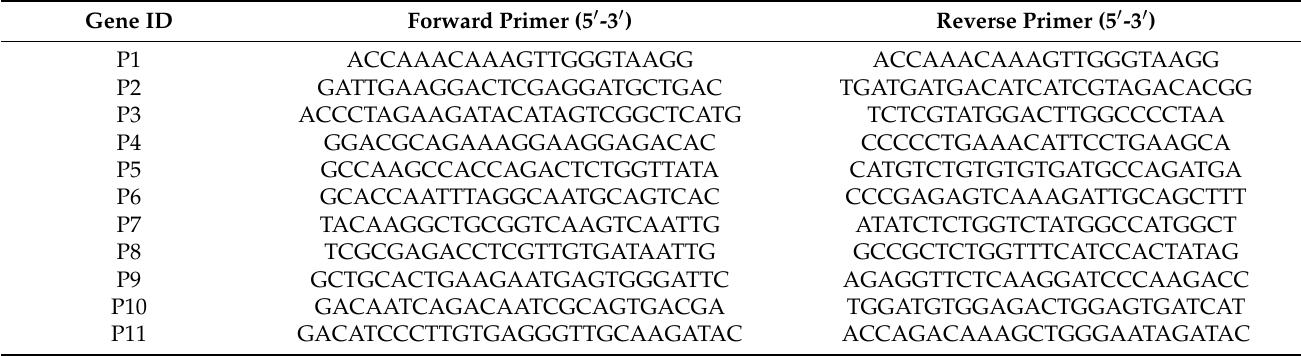
Table 1. Primers used in this